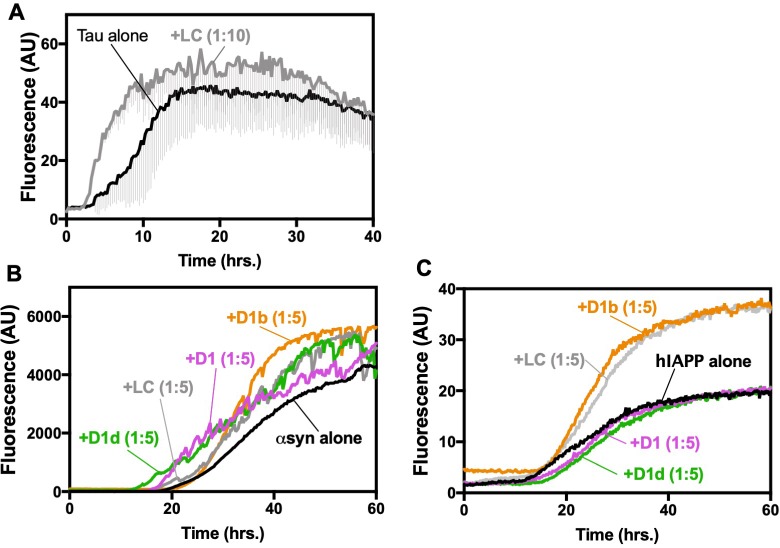
Specificy of inhibitors.(A) Control peptide inhibitor LC does not reduce fibril formation of tau40. 10 μM of tau40 was incubated at a 1:10 molar ratio to LC with 0.5 mg/ml heparin under shaking conditions at 700 RPM at 37°C. Fibril formation was monitored using ThT fluorescence. Lines show the average of three technical replicates with one standard deviation below. (B, C) Designed inhibitors are not general amyloid inhibitors. (B) 50 μM of α-synuclein was incubated at a 1:5 molar ratio to peptide inhibitors under shaking conditions at 700 RPM at 37°C. Lines show the average of three technical replicates. (C) 10 μM hIAPP was incubated at a 1:5 molar ratio to peptide inhibitors under quiescent conditions at 37°C. Lines show the average of three technical replicates.